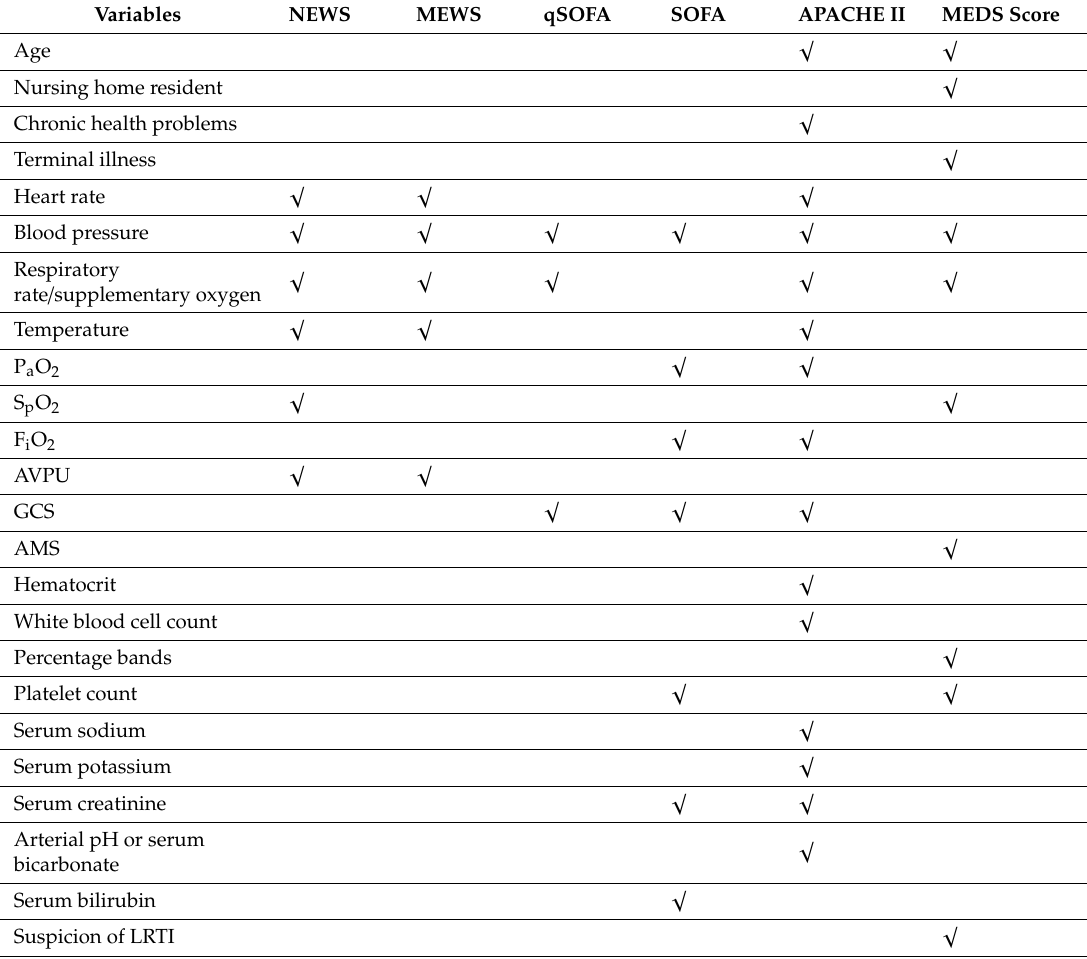
Table A1. Information required for the calculation of disease severity